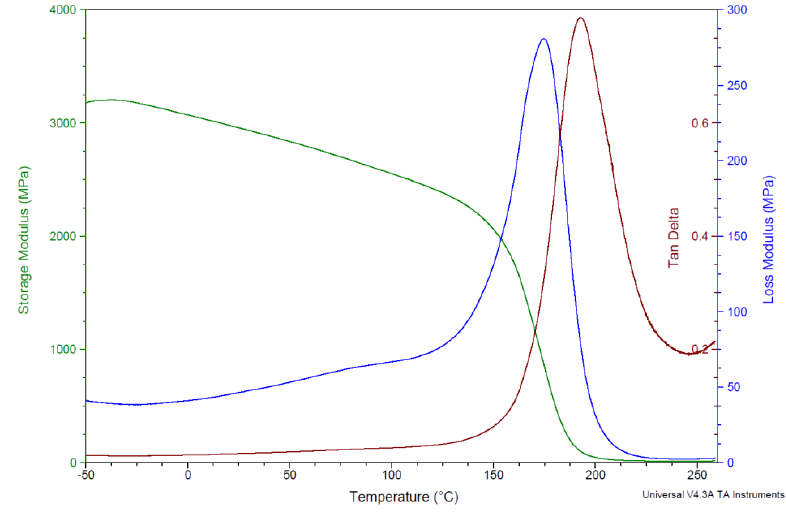
Figure 5. DMA plot of PBA-a (2 K/min from − 50 °C to 200 °C at 0.1% strain, 1Hz FF).